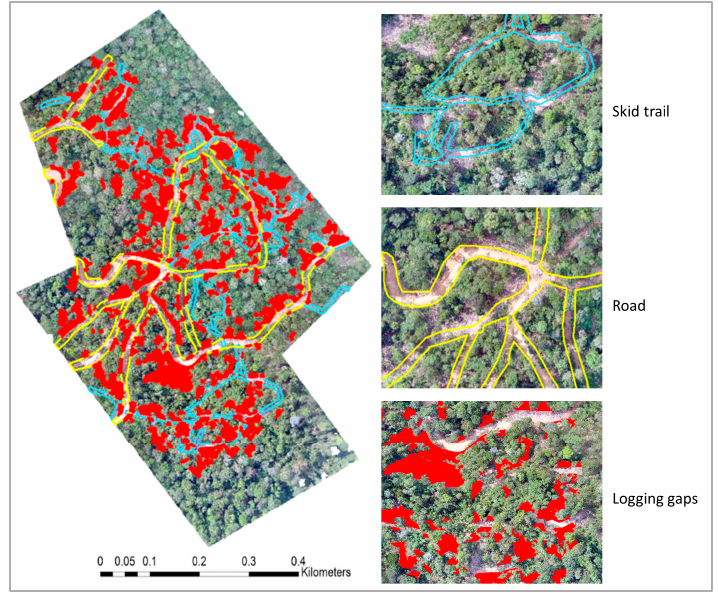
Figure 5. Roads, skid trails, and logging gaps identified as logging indicators. NDVI values for the study area were extracted from two satellite images before and after the logging operations took place. The indices values were derived from the NDVI methods using the Sentinel year 2018 and Planetscope year 2019 over the Ulu Jelai forest reserved area. The NDVI resulted from Sentinel 2018 images ranging from 0.51 to 0.71. By looking at the results in 2018, nearly all the study regions were still covered in vegetation. This is due to the imagery captured before the selective logging activities, dated 3rd June 2018. While the Planetscope image was acquired in 2019 after the selective logging oper- ations performed in December 2018, NDVI values are significantly lower than the NDVI value from the 2018 image, which has a minimum value of 0.136 and a maximum value of 0.969. The NDVI value distribution of both image displays is shown in Figure 6 The values were extracted from the 21 plots. The difference was then calculated to represent the changes in forest density to be used as potential forest parameters in carbon emission modeling. The average value of NDVI for both years 2018 and 2019 were 0.637 and 0.315, respectively.